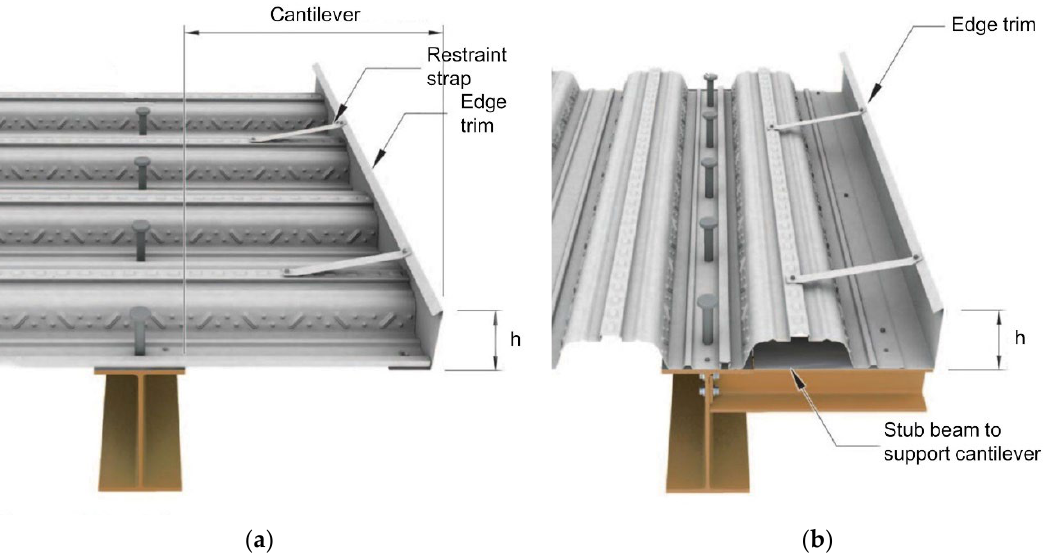
Figure 1. Typical edge configurations: ( a ) perpendicular orientation of the steel decking; and ( b ) parallel orientation of the steel decking [1] .